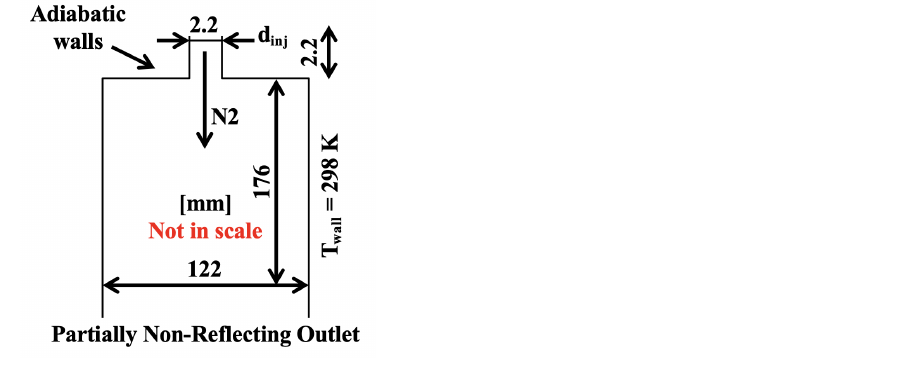
Figure 2. Sketch of the computational domain in the non-reacting Mayer’s test case.